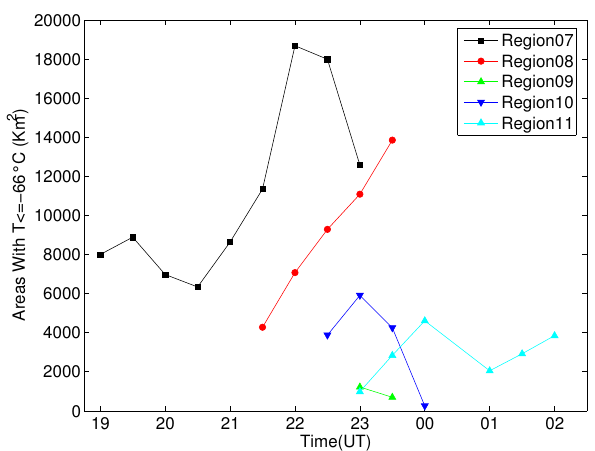
Fig. 8. Overall cloud cover ( T < − 66 ◦ C) temporal evolution of 25– 26 October 2005 convective regions.